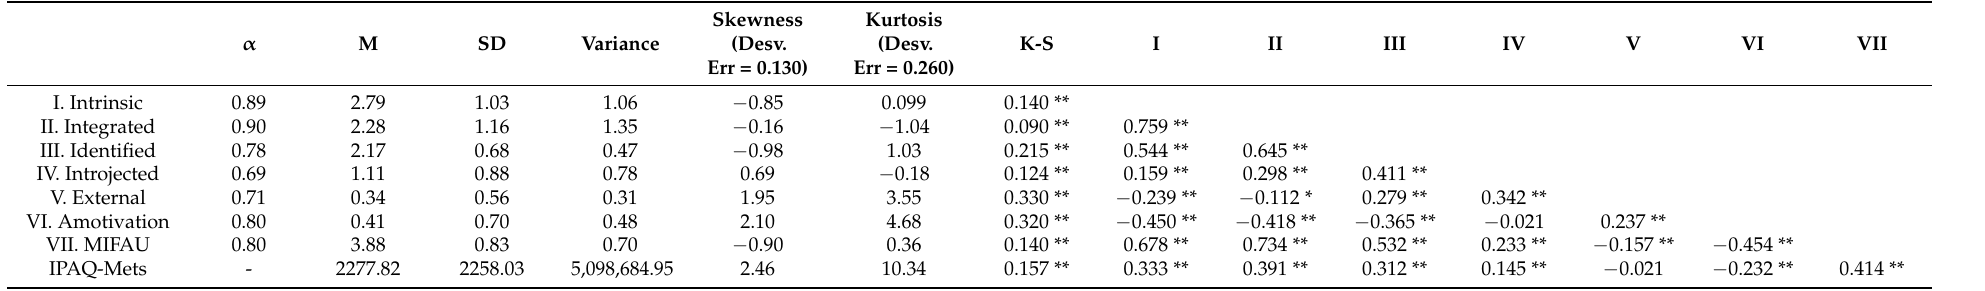
Table 2. Descriptives of the